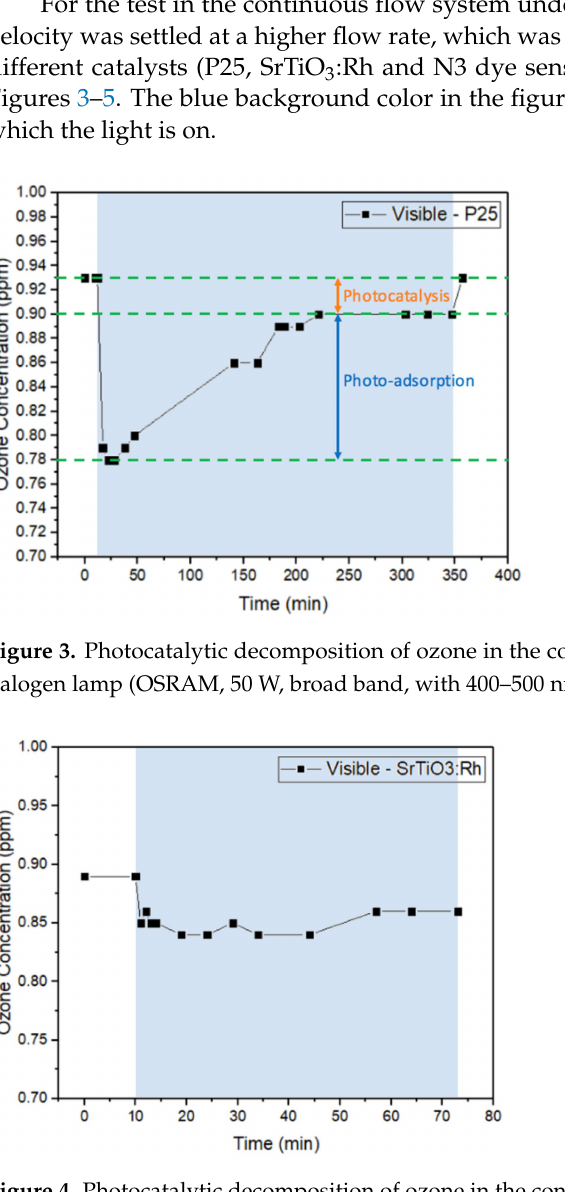
Figure 4. Photocatalytic decomposition of ozone in the continuous flow system by SrTiO 3 :Rh under the halogen lamp (OSRAM, 50 W, broad band, with 400–500 nm bandpass